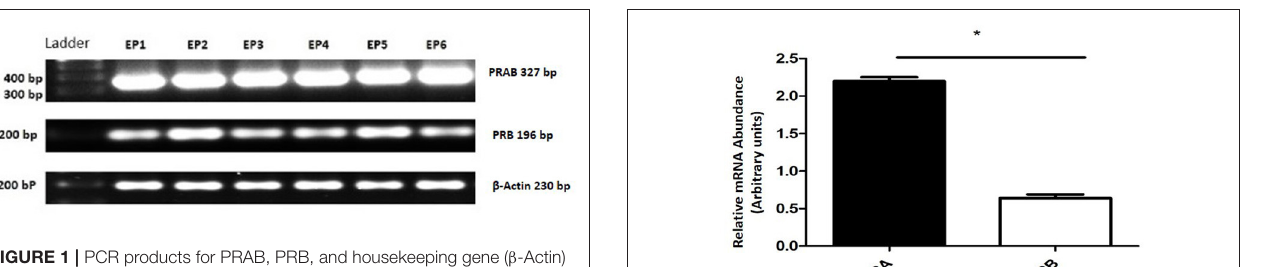
FIGURE 1 | PCR products for PRAB, PRB, and housekeeping gene ( β -Actin) of equine placental tissue samples (EP) 1–6. Bands appear at the expected size (PRAB 327 bp, PRB 196 bp and β -Actin 230 bp).